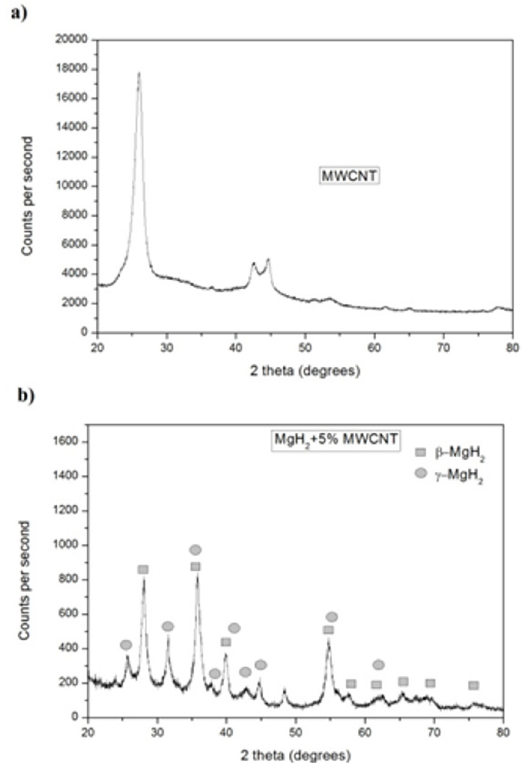
Figure 2. XRD patterns of multi-walled carbon nanotubes and MgH2 milled for 20 min with MWCNT Only